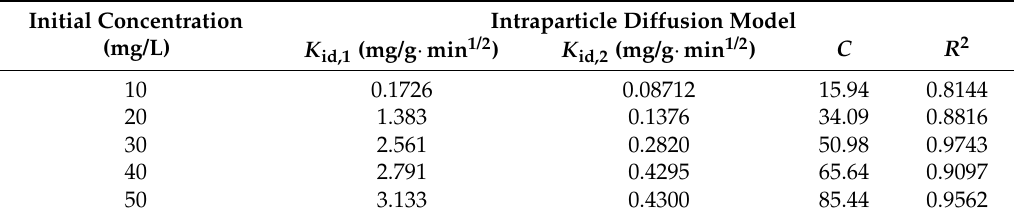
Figure 8. Intra-particle diffusion treatment of MV onto α -Fe 2 O 3 @PHCMs at initial concentrations. Table 4. Intra ‐ particle rate parameters and diffusion coefficients at different initial concentrations. Table 4. Intra-particle rate parameters and diffusion coefficients at different initial